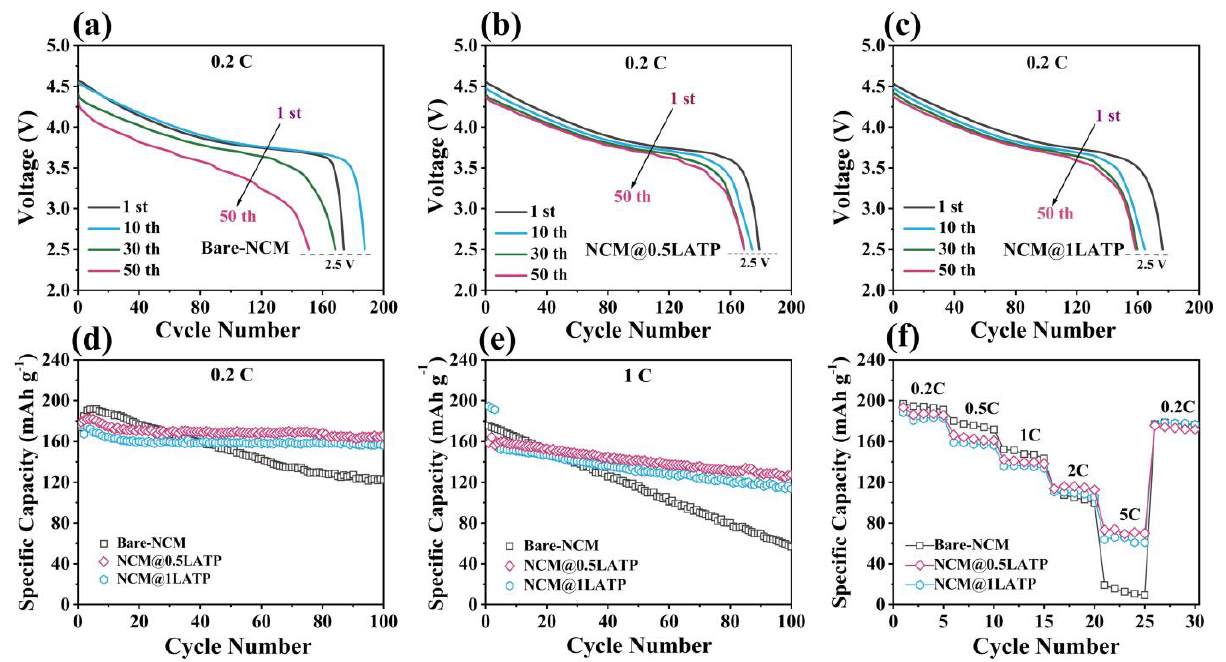
ples. For the bare NCM sample (Figure 7a), a significant declination in both voltage and